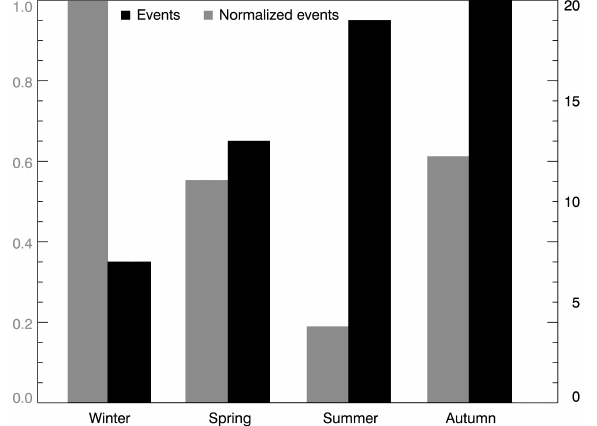
Figure 4. Seasonal distribution (black) and seasonal normalized distribution (grey) of the detected lightning–LEP events. The sea- sonal distribution has been normalized by the seasonal total number of lightning flashes occurring over the domain and scaled according to the winter season.